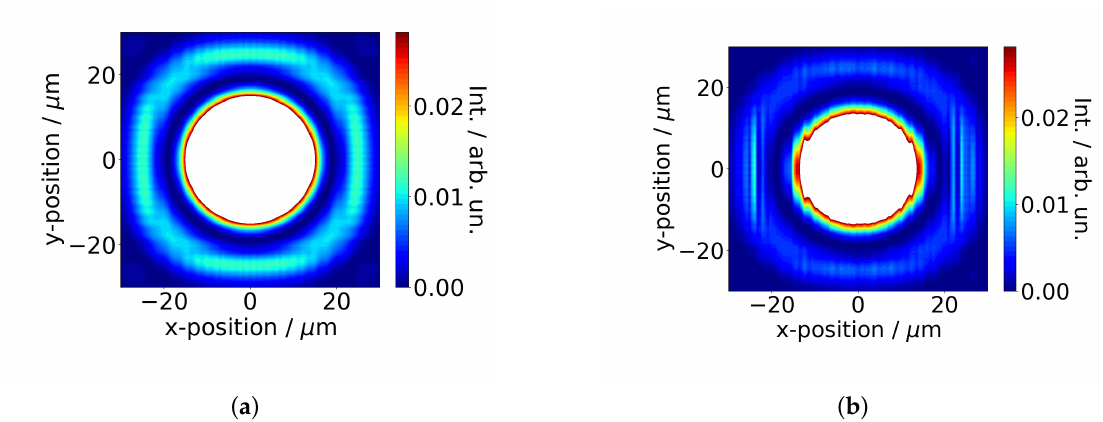
Figure 5. Simulated far-field distribution of the reflected light at 50 µ m distance from the surface. ( a ) Unstructured titanium. ( b ) Sinusoidally structured titanium surface (600 nm period, 300 nm